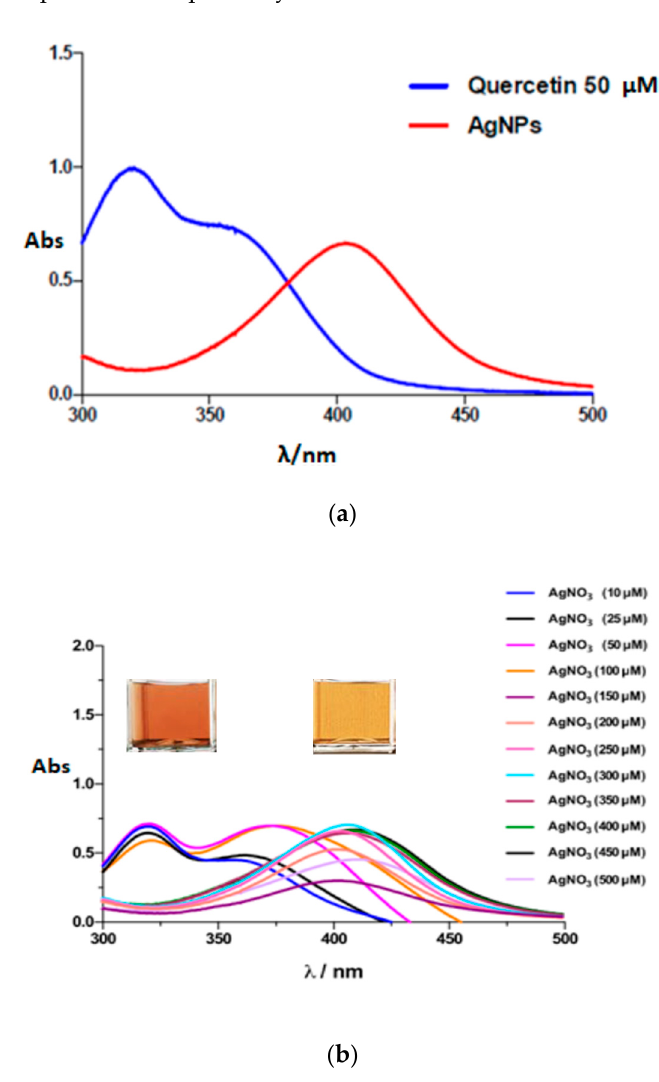
Figure 2. ( a ) UV-Vis spectra of a colloidal solution of QUC 50 μ M in 50 mM PBS buffer pH (blue curve) and of AgNPs (diluted 1:4) (red curve); ( b ) UV-Vis spectra of a colloidal solution of AgNPs after 20 min (diluted 1:4) in 50 mM PBS at pH 7 obtained with different concentrations of AgNO 3 .